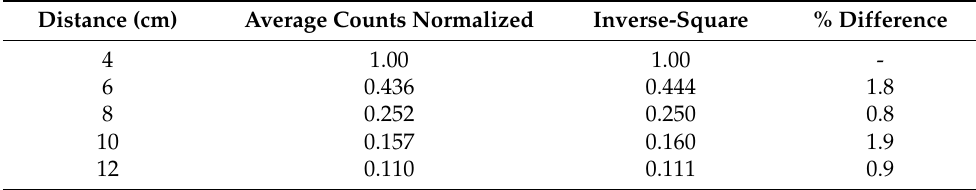
Figure 11. Dose rate dependence results. The relationship between OSLD counts and absorbed dose with varying dose rates. The data can be modeled by Equation (2), which is represented by the dashed line. Table 3. Theoretical comparison. This table compares the dose rate between the measurements made and the theoretical calculations.